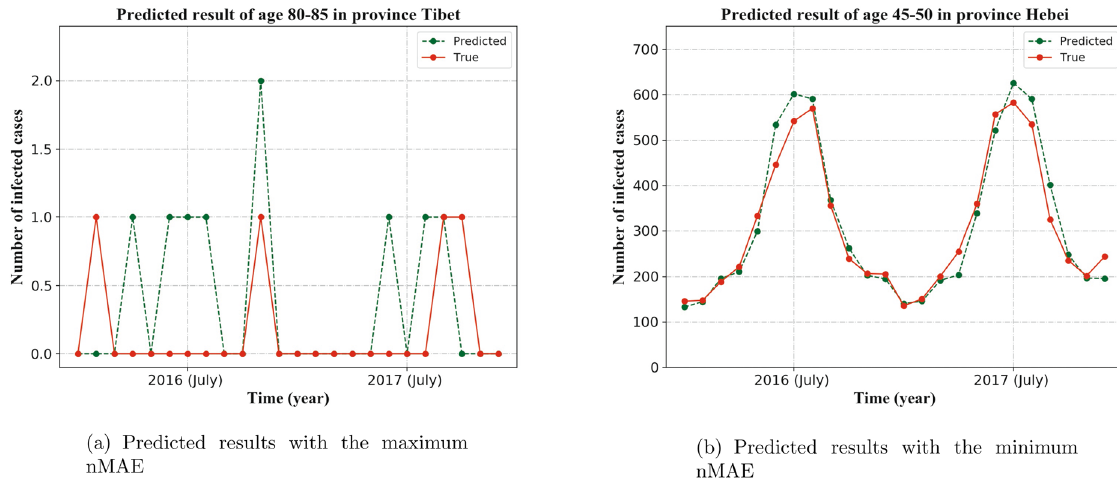
Figure 8. Demonstration of worst and best predictions. (See Supplementary Tables 7, 8 in Supplementary material to obtain the detailed data). The predicted result is measured by